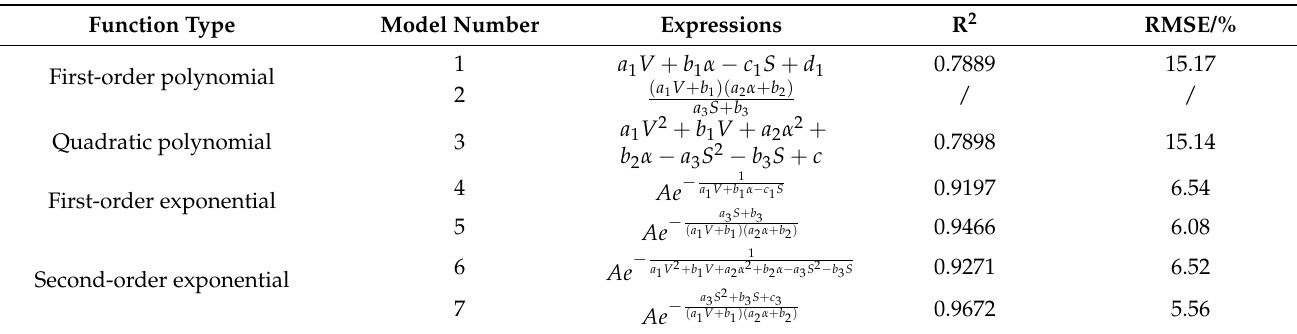
Table 2. Comparison of fitting results of different